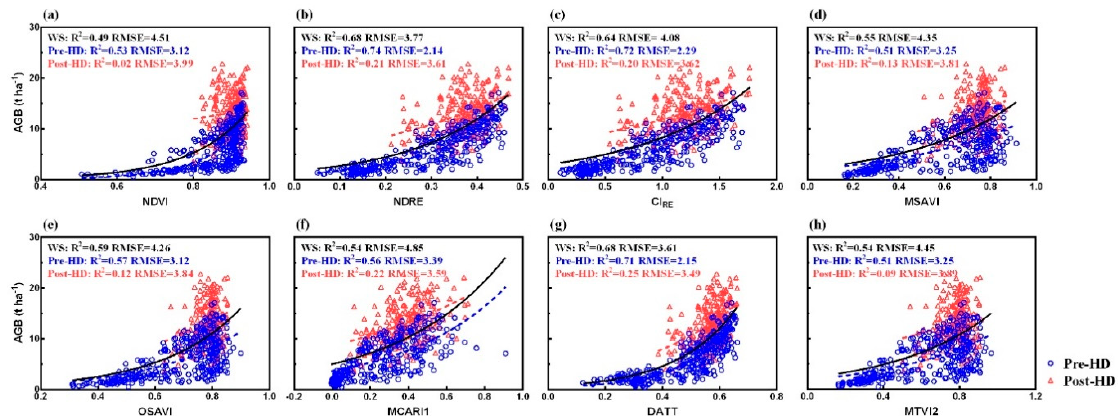
Figure 4. Aboveground biomass (t ha − 1 ) plotted against vegetation indices: ( a ) NDVI; ( b ) NDRE; ( c ) CI RE ; ( d ) MSAVI; ( e ) OSAVI; ( f ) MCARI1; ( g ) DATT; ( h ) MTVI2. WS represents the whole season, Pre-HD represents pre-heading stages and Post-HD represents post-heading stages.